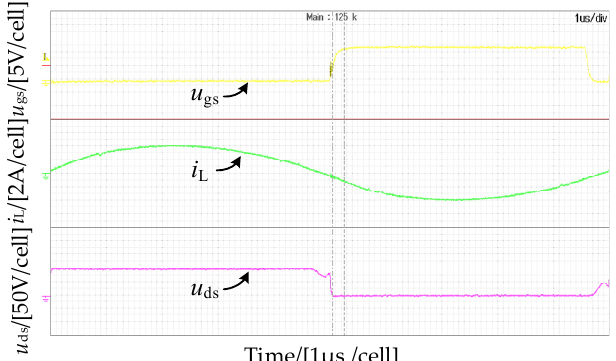
Figure 34. Bridge-arm B soft-switching waveform diagram.